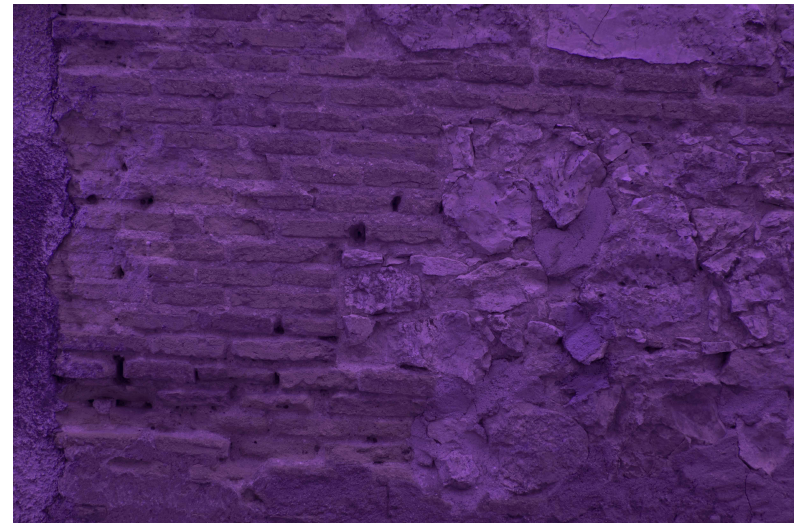
Figure 10. Picture of the wall with modified camera and ZB2 ultraviolet